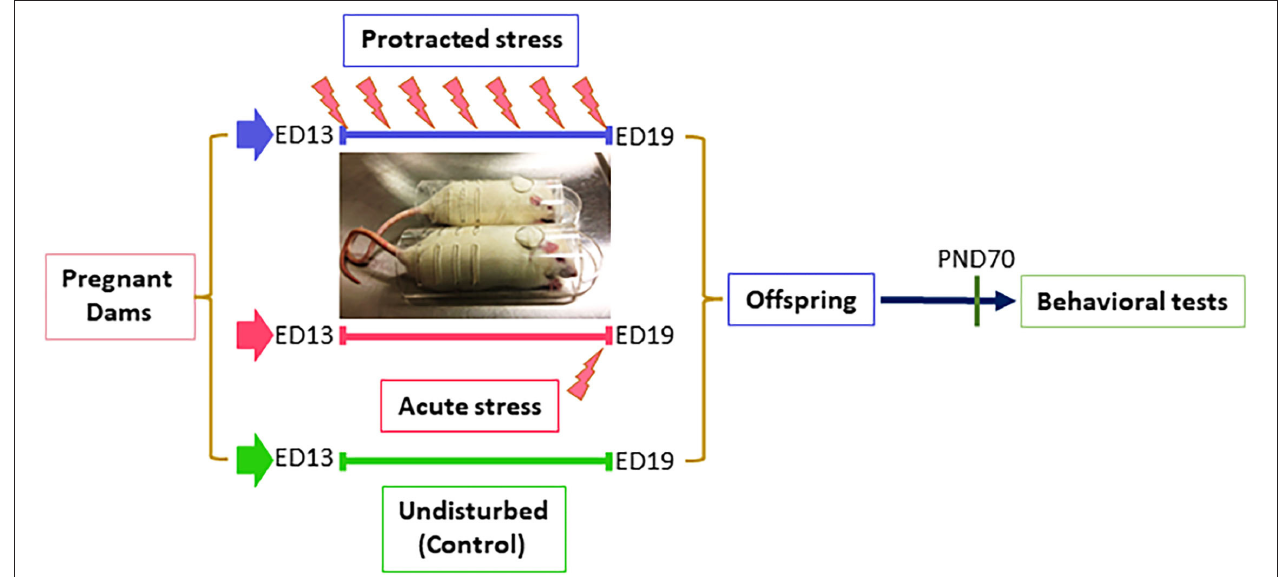
FIGURE 1 | Diagram of stress procedure in this study. Pregnant dams were divided into three groups: control, protracted, and acute stress, in which dams in control group left undisturbed while dams in protracted group were subjected to 7 days repeated restraint stress (twice daily for 30min) from ED13–19, dams in acute group received a single stress on gestation day